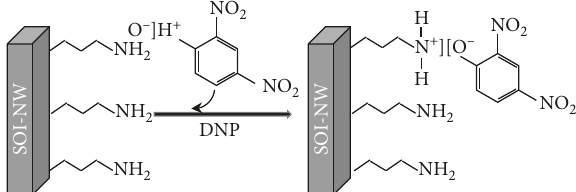
Figure 2: Scheme of DNP detection with APTES-modified